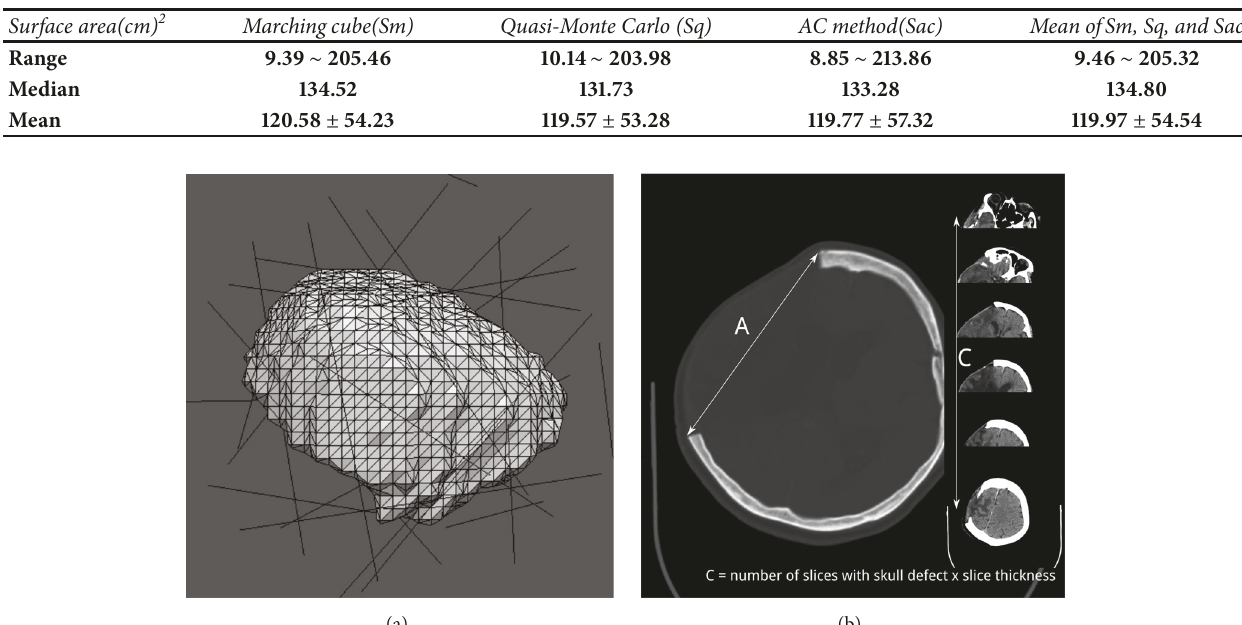
Figure 2: Illustration of the surface area estimation methods. (a) The marching cube method entails estimating the surface area by splitting the surface into small polygons (triangles in our implementation). The quasi-Monte Carlo method involves estimating the surface area by counting the number of intersections between the skull flap and lines generated using a low-discrepancy sequence. (b) AC method. 𝐴 is the longest length of craniectomy on the axial slices, and C is the product of the number of axial cuts induced by craniectomy and slice